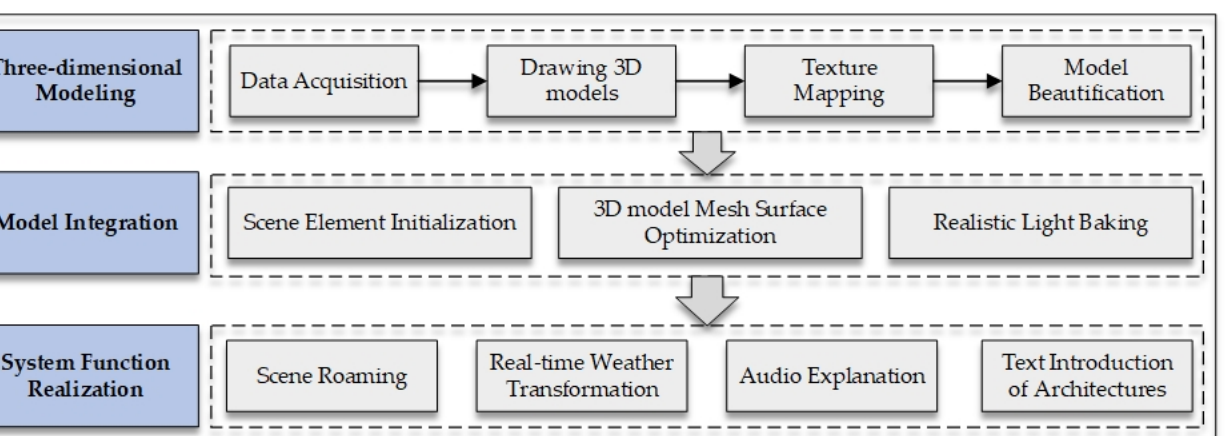
Figure 7. Cultural landscape 3D model construction and visualization workflow.